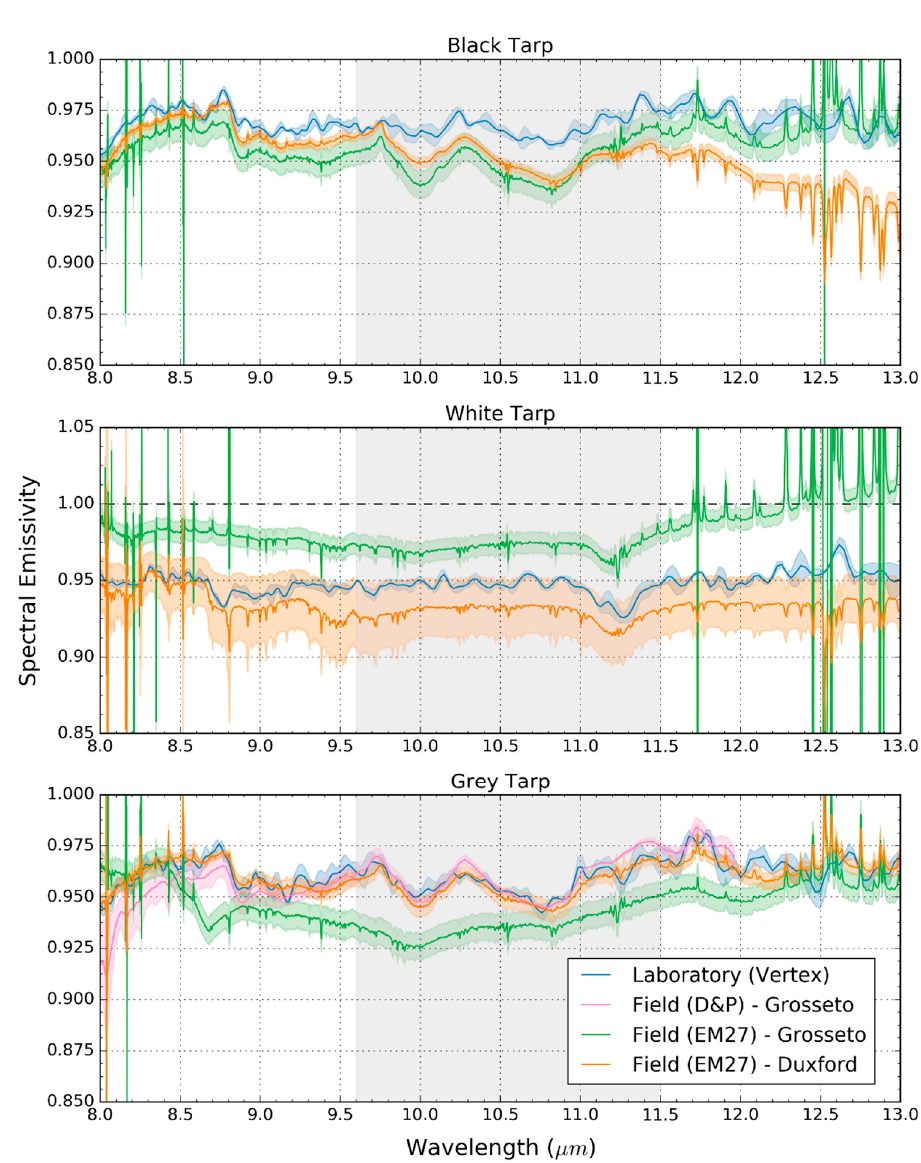
Figure 10. Spectral emissivities of (top to bottom) the black tarpaulin, white tarpaulin, and grey tarpaulin based on data collected in the laboratory (Vertex) and field using (i) the Bruker EM27 FTIR spectrometer (EM27) in both Grosseto, Italy and Duxford, UK and (ii) the Designs and Prototypes µ FTIR spectrometer (D&P, grey tarpaulin only). Values are the mean of all measurements, with the surrounding shaded area indicating the corresponding uncertainty as detailed in Section 3.1. The numbers of measurements made of each sample were listed in Table 3. Grey shaded area indicates the spectral range of the Heitronics KT15.85 IIP radiometer used for the emissivity box